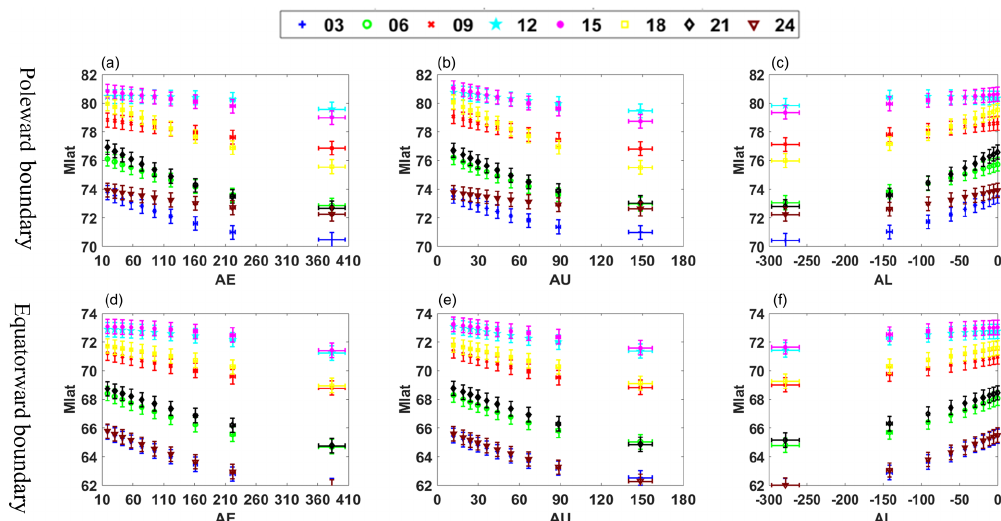
Figure 7. Response of the magnetic latitude of poleward (a, b, c) and equatorward (b, e, f) boundaries to AE, AU, and AL respectively at 00:30, 00:60, 00:90, 12:00, 15:00, 18:00, 21:00, and 24:00MLT.